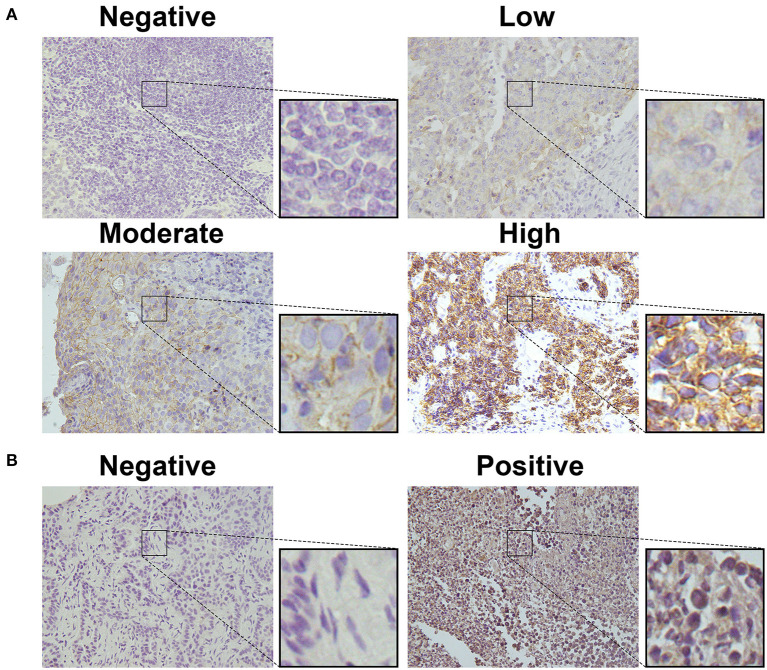
CD155 and TIGIT expression characteristics in PSCCE tissues. Representative images for (A) negative, low, moderate, and high CD155 expression; (B) negative and positive TIGIT expression (original magnification ×400).